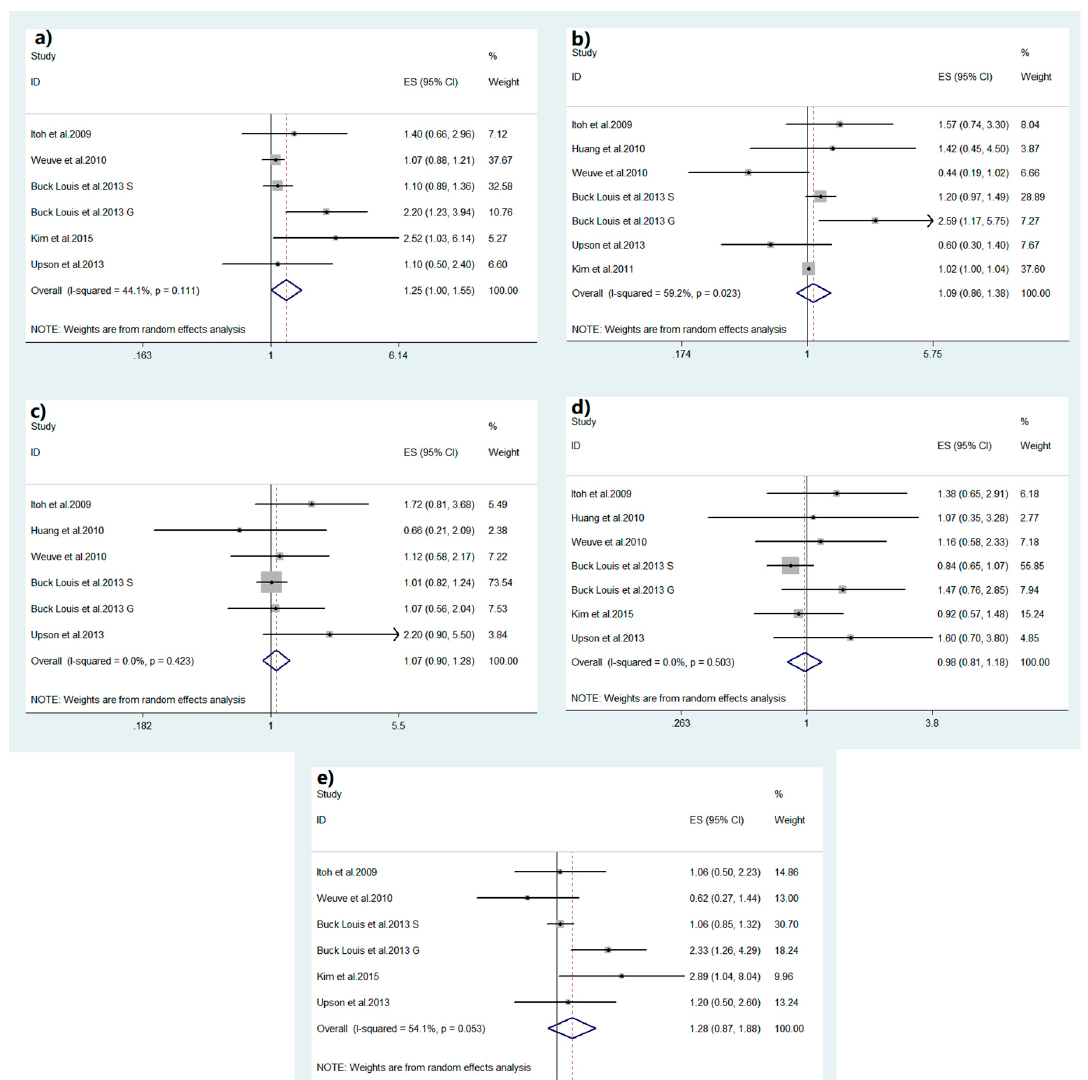
Figure 2. Forest plots of studies included in the meta-analyses: ( a ) MEHHP and endometriosis; ( b ) MEHP and endometriosis; ( c ) MEP and endometriosis; ( d ) MBzP and endometriosis; ( e ) MEOHP and endometriosis.